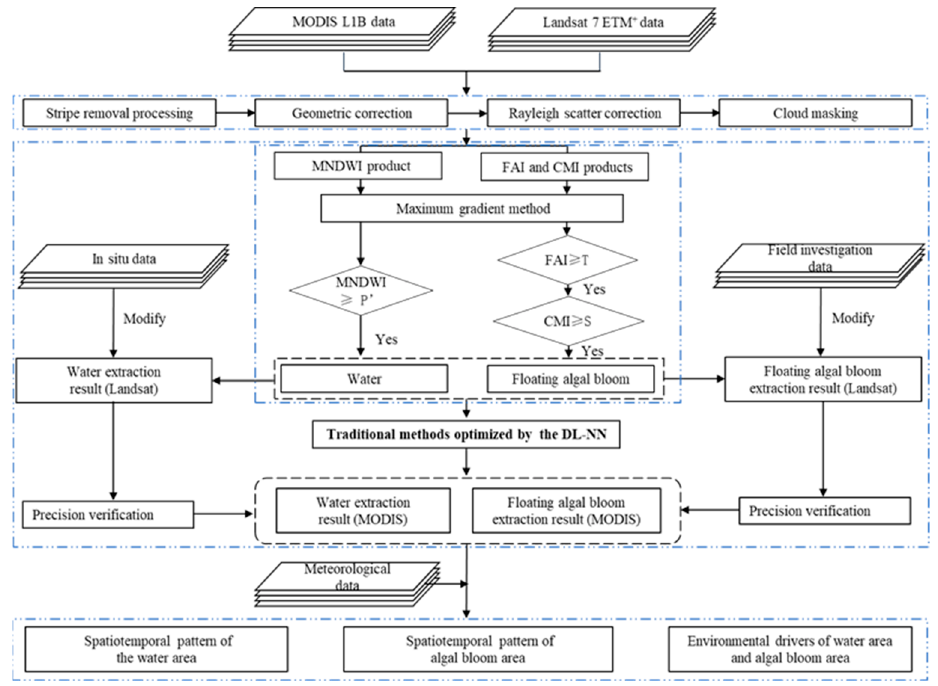
Figure 2. Diagram of the overall methodology used in this study.